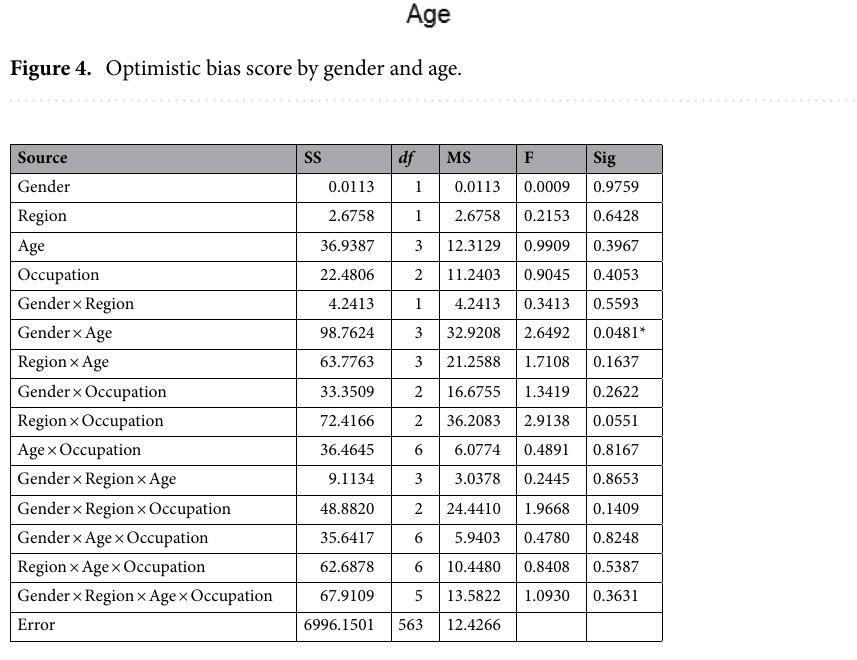
Table 6. Four-way analysis of variance of social trust with gender, region, age and occupation. * p <